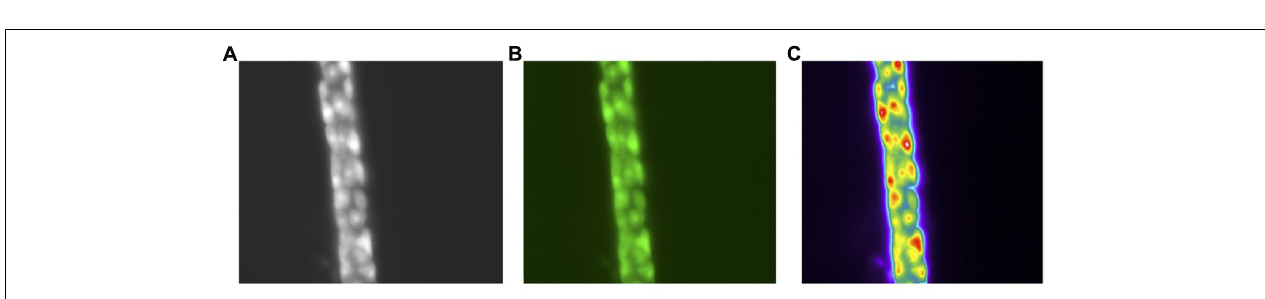
FIGURE 1 | Schematic representations of the stomach (A) and oxyntic gland (B) . (A) The stomach is divided into two functional regions, the oxyntic region (composed of the cardia, fundus, and corpus) and the pyloric region (composed of the antrum and pylorus). (B) A representative oxyntic gland from the oxyntic region of the stomach features a gastric pit, isthmus, neck, and base. A variety of stomach cell types exist, including parietal cells, enterochromaffin cells, and mucous cells.